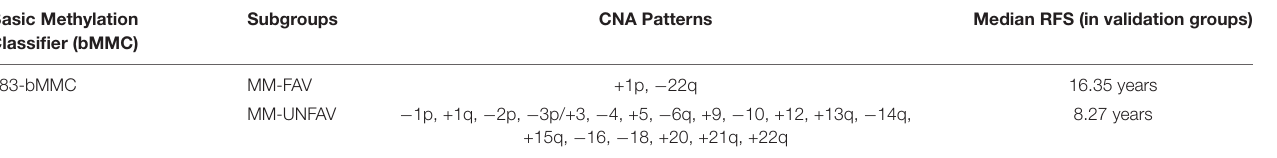
TABLE 3 | The 283-bMMC model subgroups (2017).